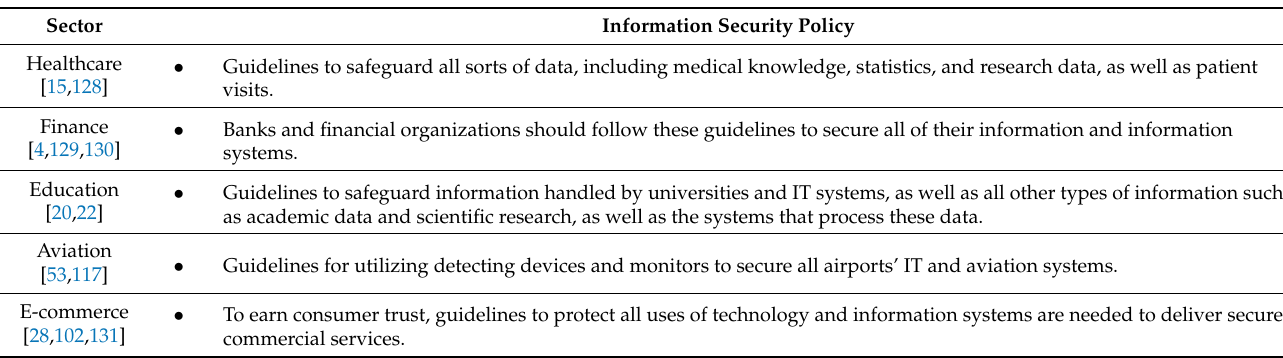
Table 8. Information security policy among different